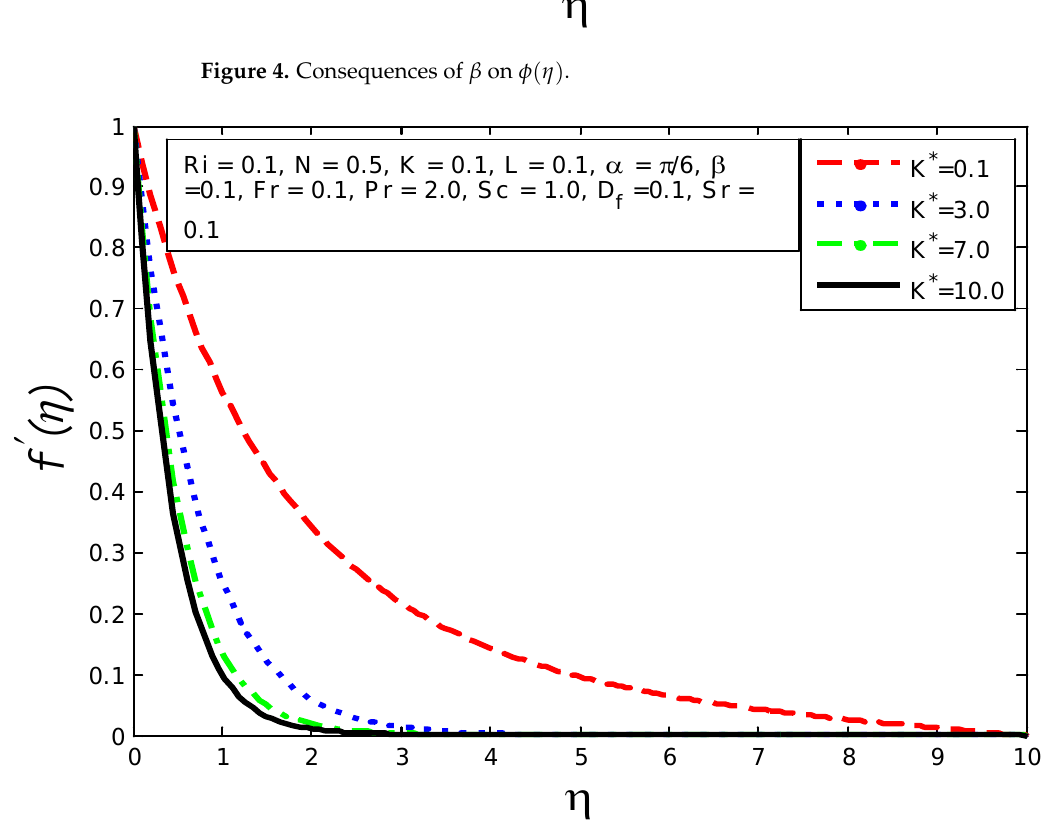
Figure 5. Consequences of K ∗ on f (cid:48) ( η )